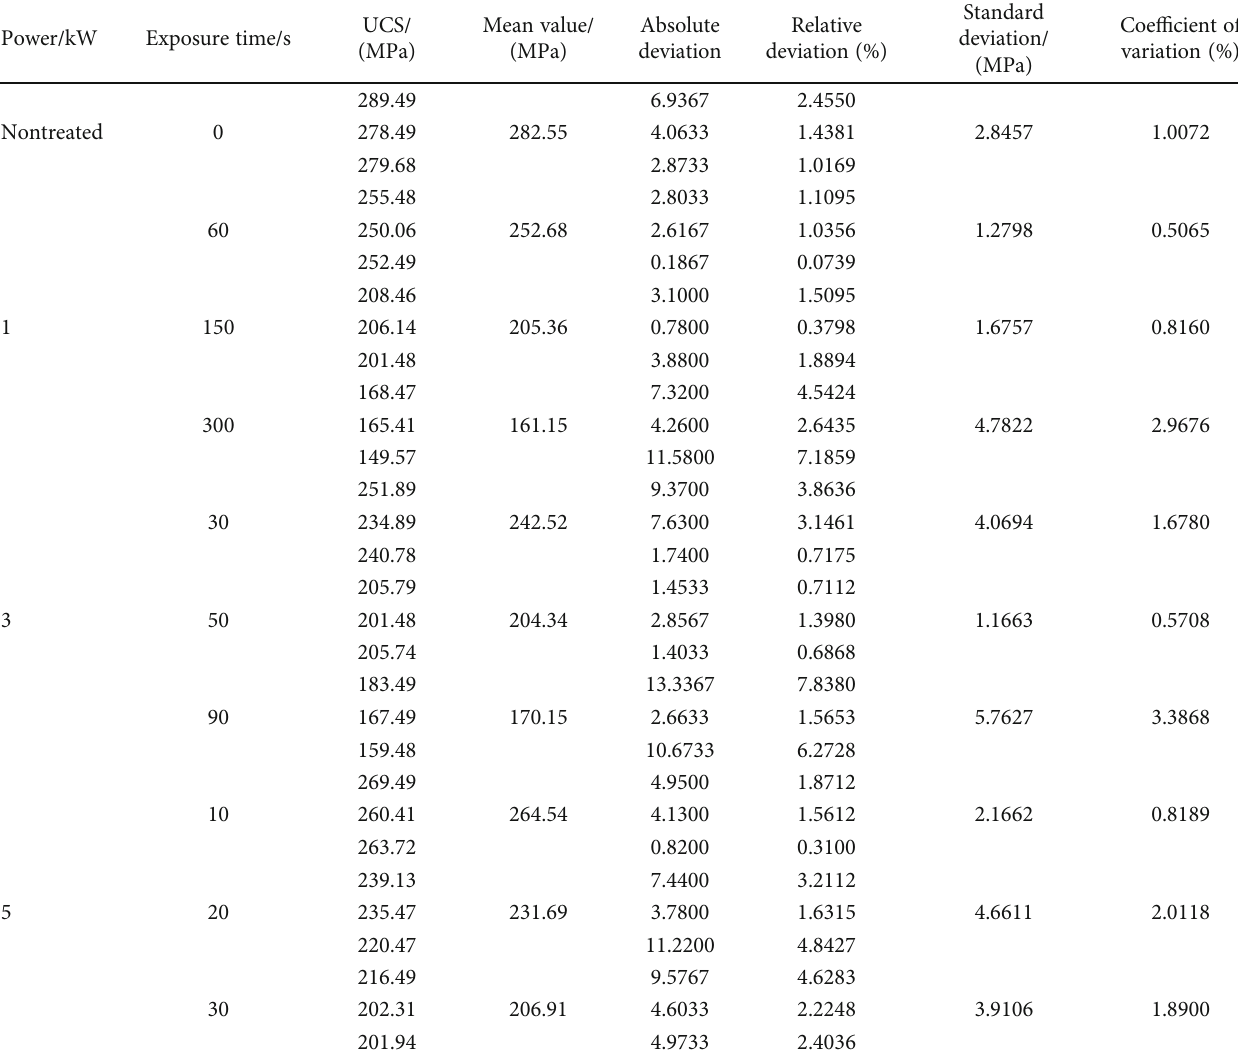
Table 4: Testing results of UCS induced by microwave